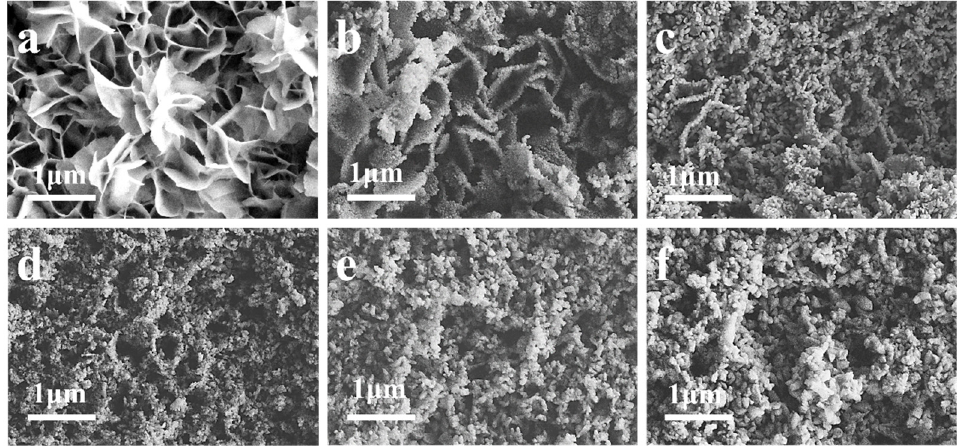
Figure 4. FE-SEM images of anion-exchange films prepared with different reaction times: 0 min ( a ), 5 min ( b ), 10 min ( c ), 15 min ( d ), 30 min ( e ) and 1 h ( f ). 5 min ( b ), 10 min ( c ), 15 min ( d ), 30 min ( e ) and 1 h ( f